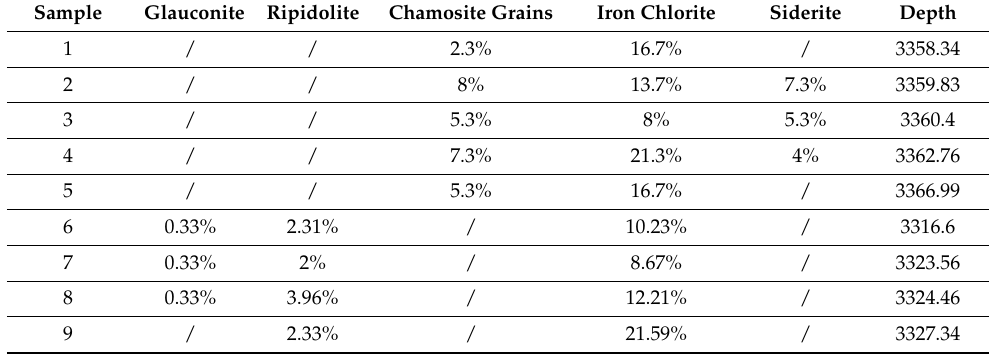
Table 2. Percentage of clay minerals in rock samples acquired from geological Unit 4 and Unit 5.